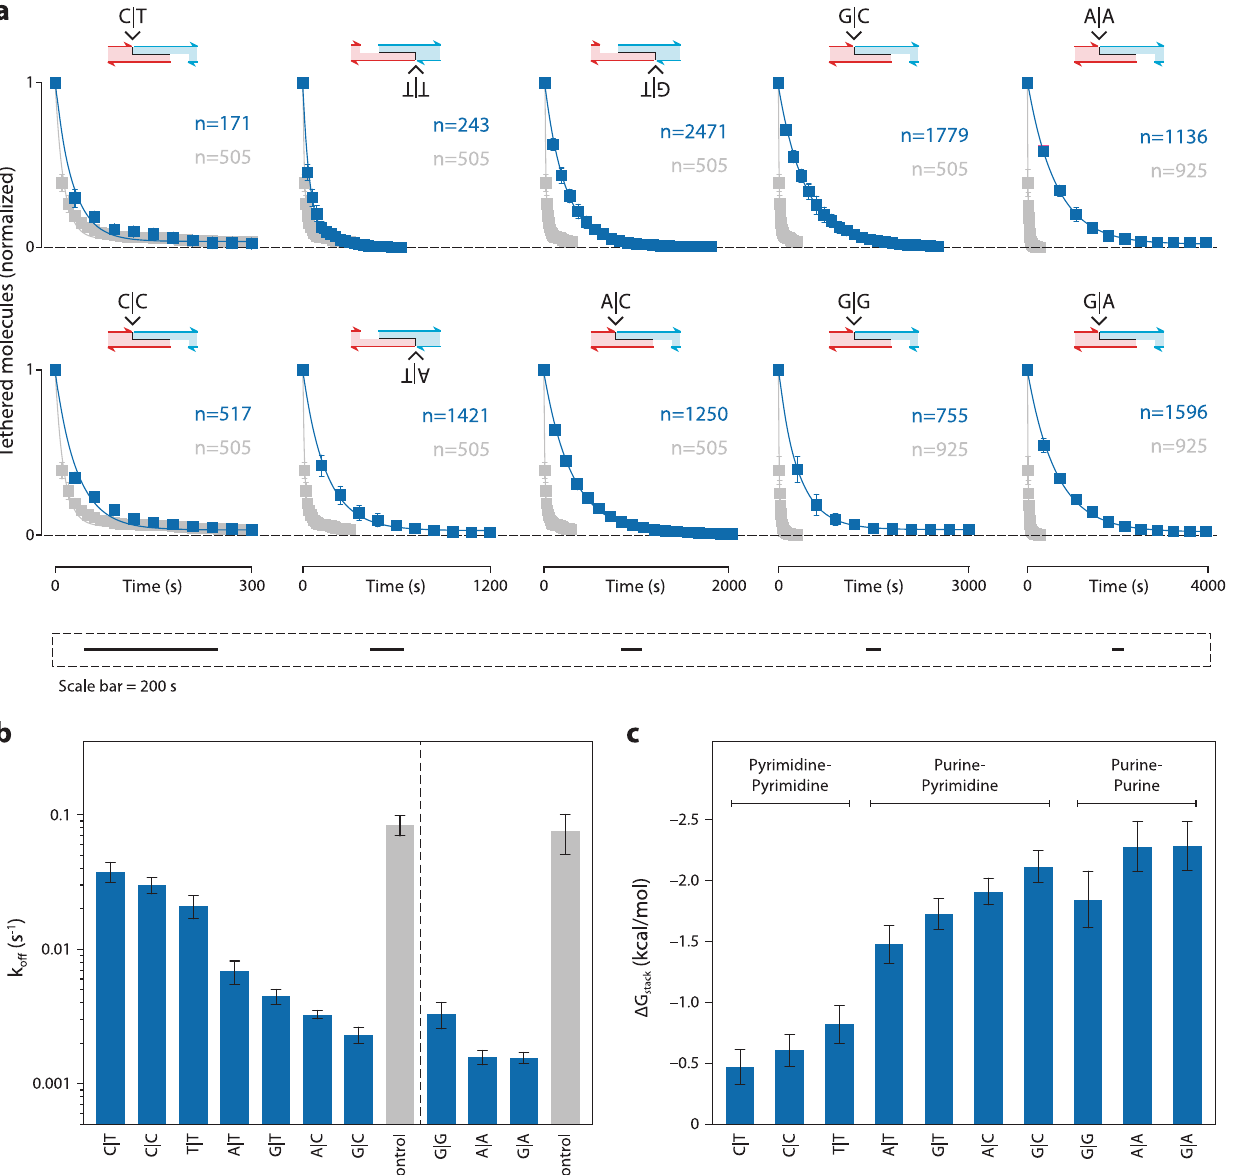
Fig. 4 | Comprehensive study of DNA base stacking. a Decay curves and single- calculated from panel ( b ). Data in ( a , b ) presented as mean values +/ − standard deviation from three independent data sets (shown in Supplementary Figs. 7 – exponential fi ts obtained for unique base stacking combinations (blue) and their controls (gray) at a constant force of 15 pN. b Off-rates of DNA tethers containing various base stacks and their corresponding controls. c Base stacking energies Table 1 | Individual base stacking energies determined using CFM G|A A|A G|G G|C A|C